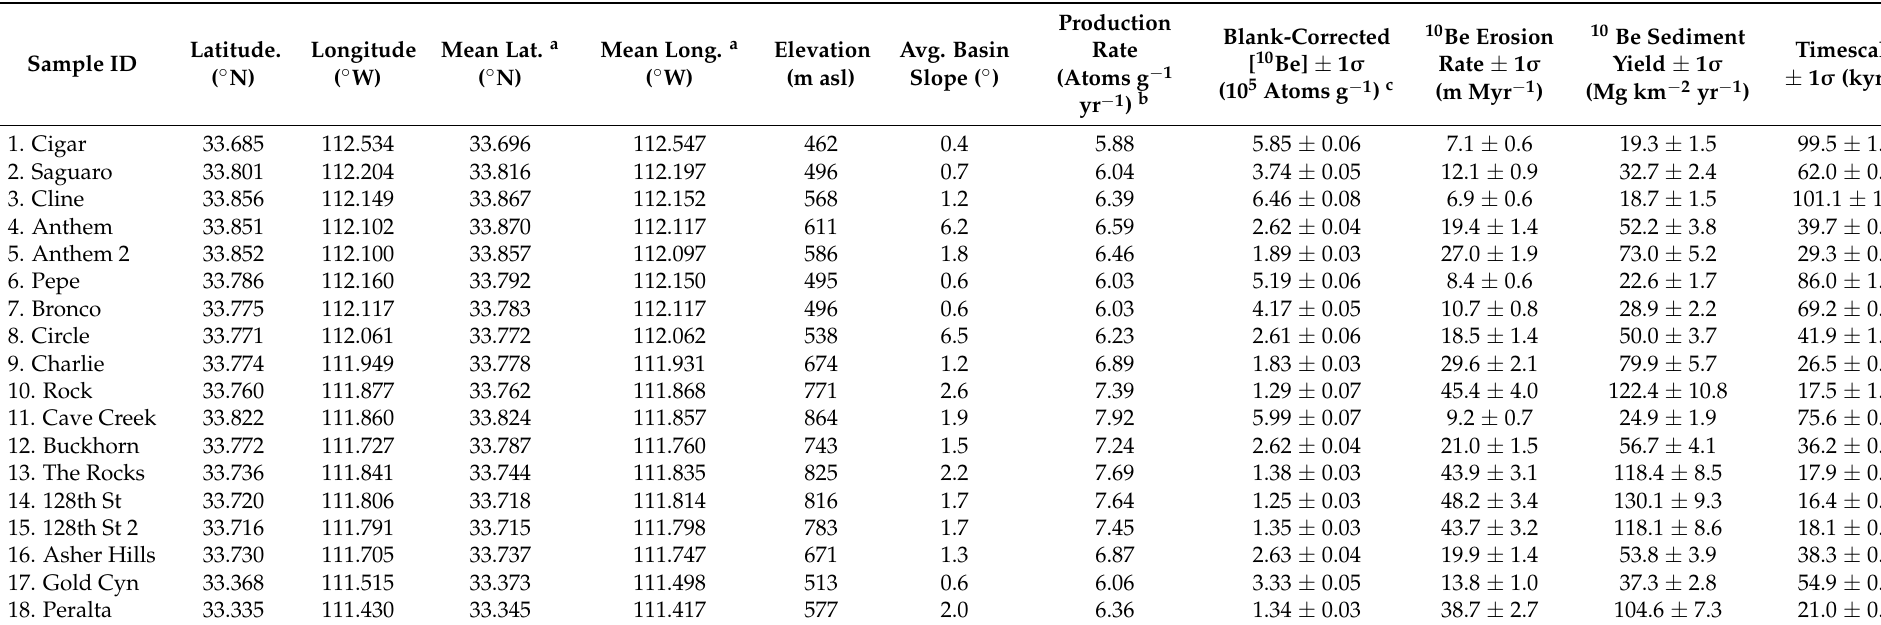
Table 3. CADRs based on cosmogenic 10 Be analyses. The sample ID corresponds to the different watersheds in the Phoenix Metropolitan Region (PMR) that are presented in Figure 2.